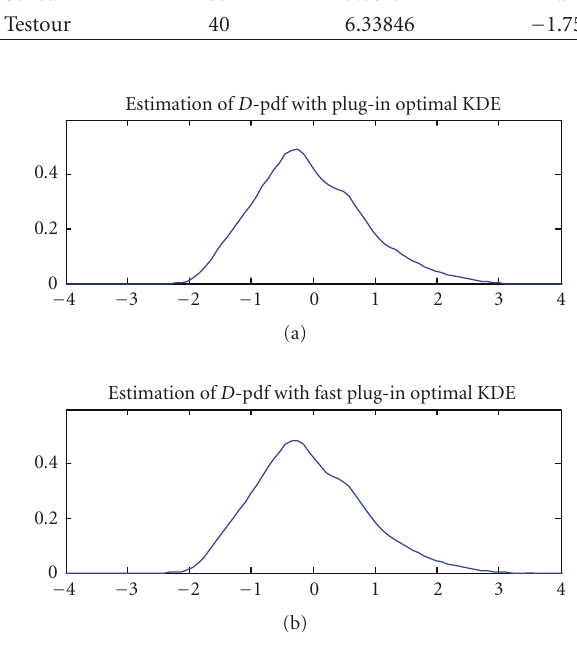
Figure 5: Estimation of the D -pdf of Sened by optimal plug-in KDE and fast plug-in KDE.